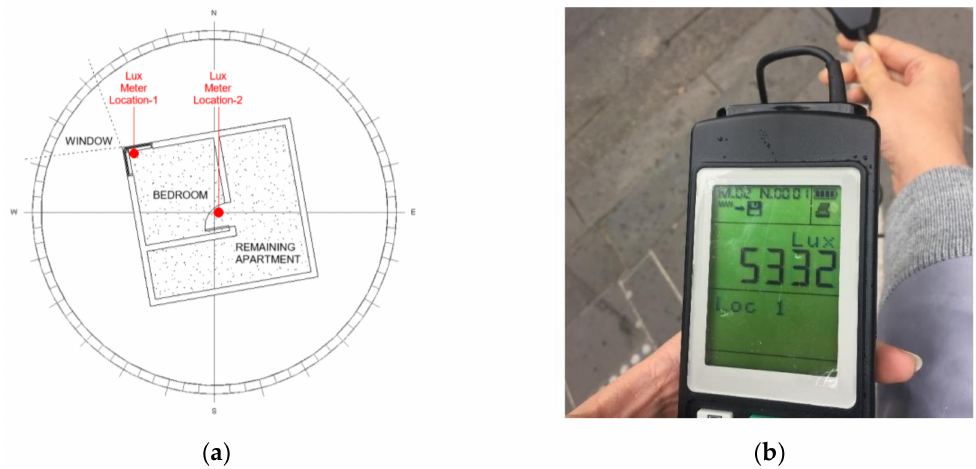
Figure 3. ( a ) Measurement location in the bedroom ( b ) measuring external